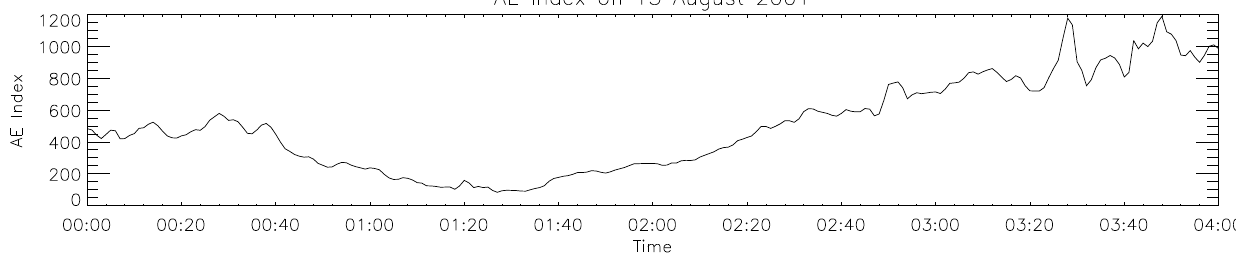
Fig. 2. The AE index (nT) for the period 00:00 UT to 04:00 UT on 13 August 2001. Of note is the intensification around 02:50 UT of ∼ 200nT which is associated with dynamics in the plasma sheet.